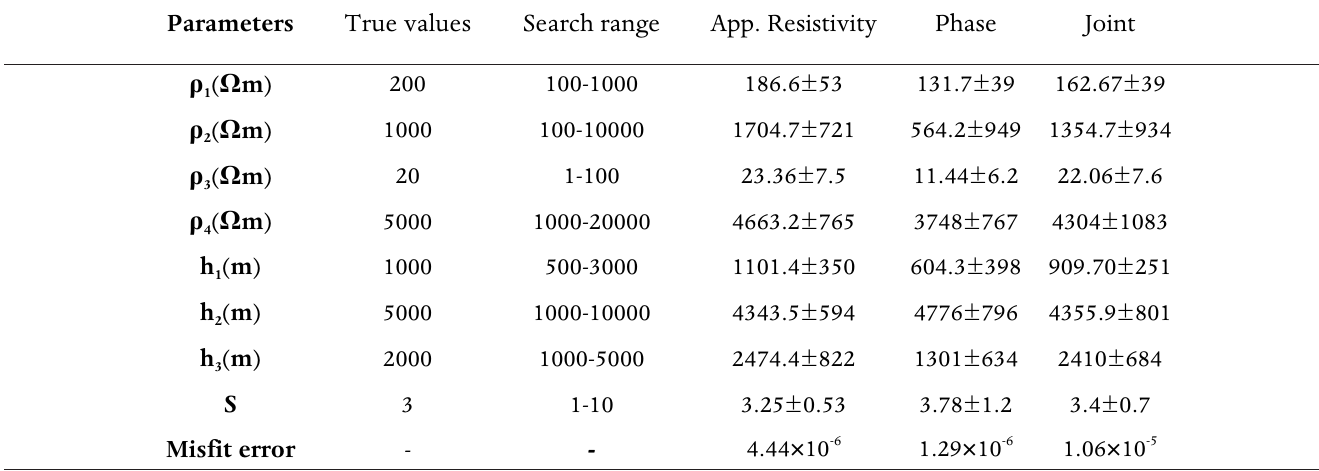
Table 4. Model 2: inversion results with optimization of static shift.